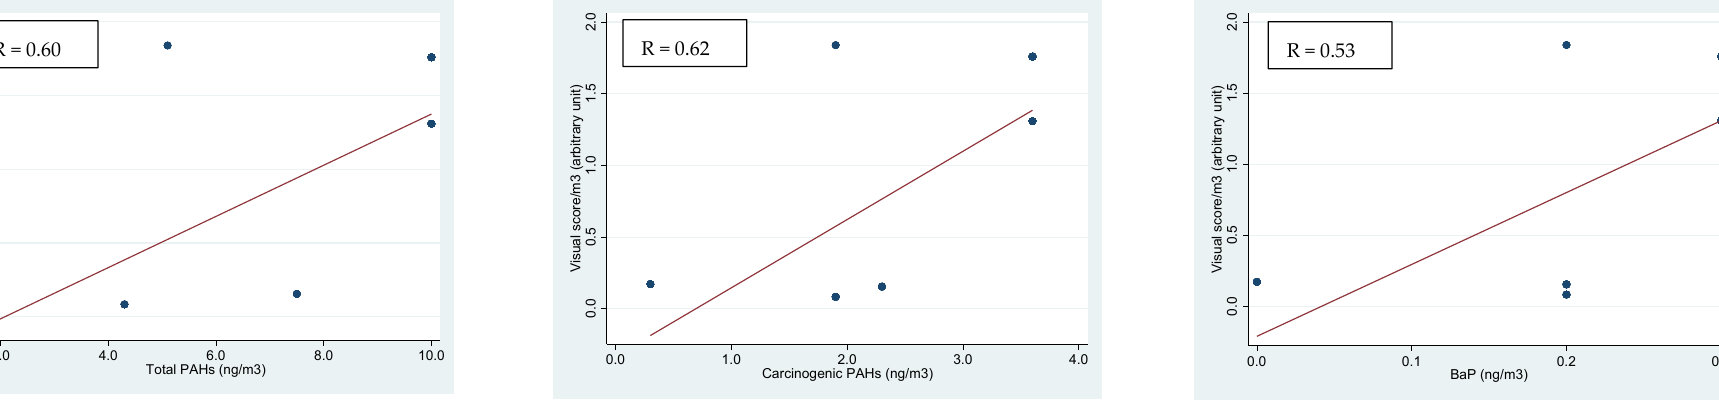
Figure 2. Linear regressions of DNA damage in leukocytes (comet in vitro) on total PAHs, carcinogenic PAHs and BaP concentrations in PM 3–10 and the Spearman’s correlation coefficients ( p < 0.001 for all comparisons).